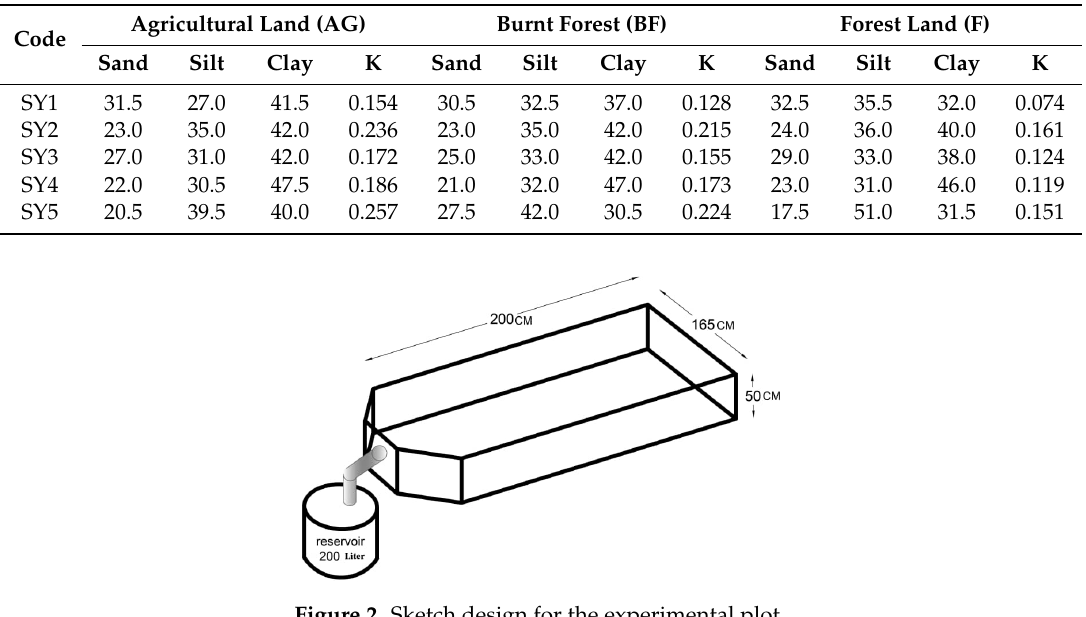
Table 1. Experimental characteristics of the five locations studied.